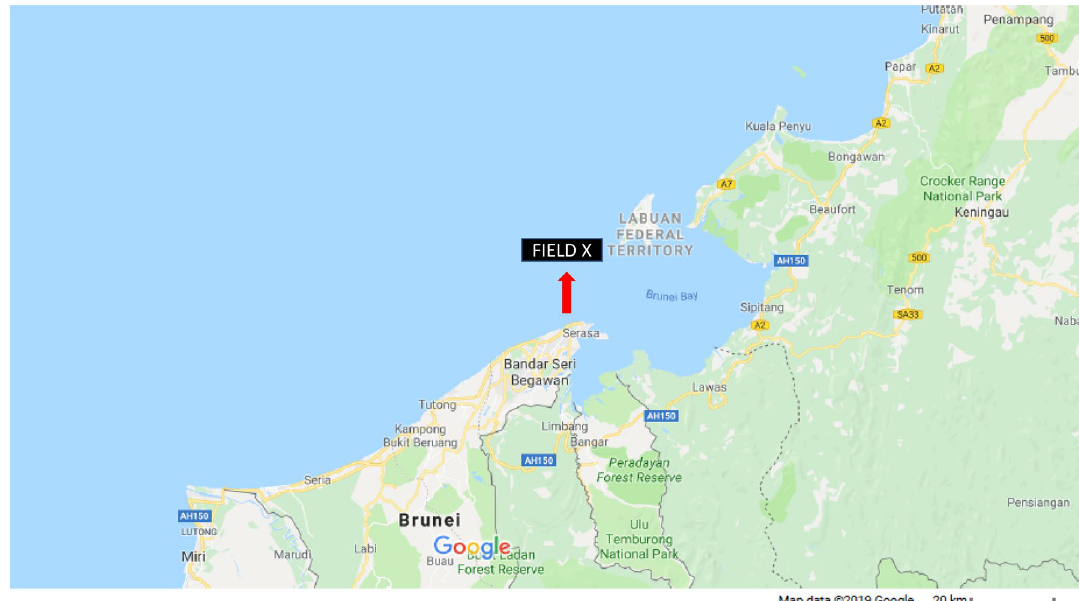
Fig. 1 Map showing the location of Field